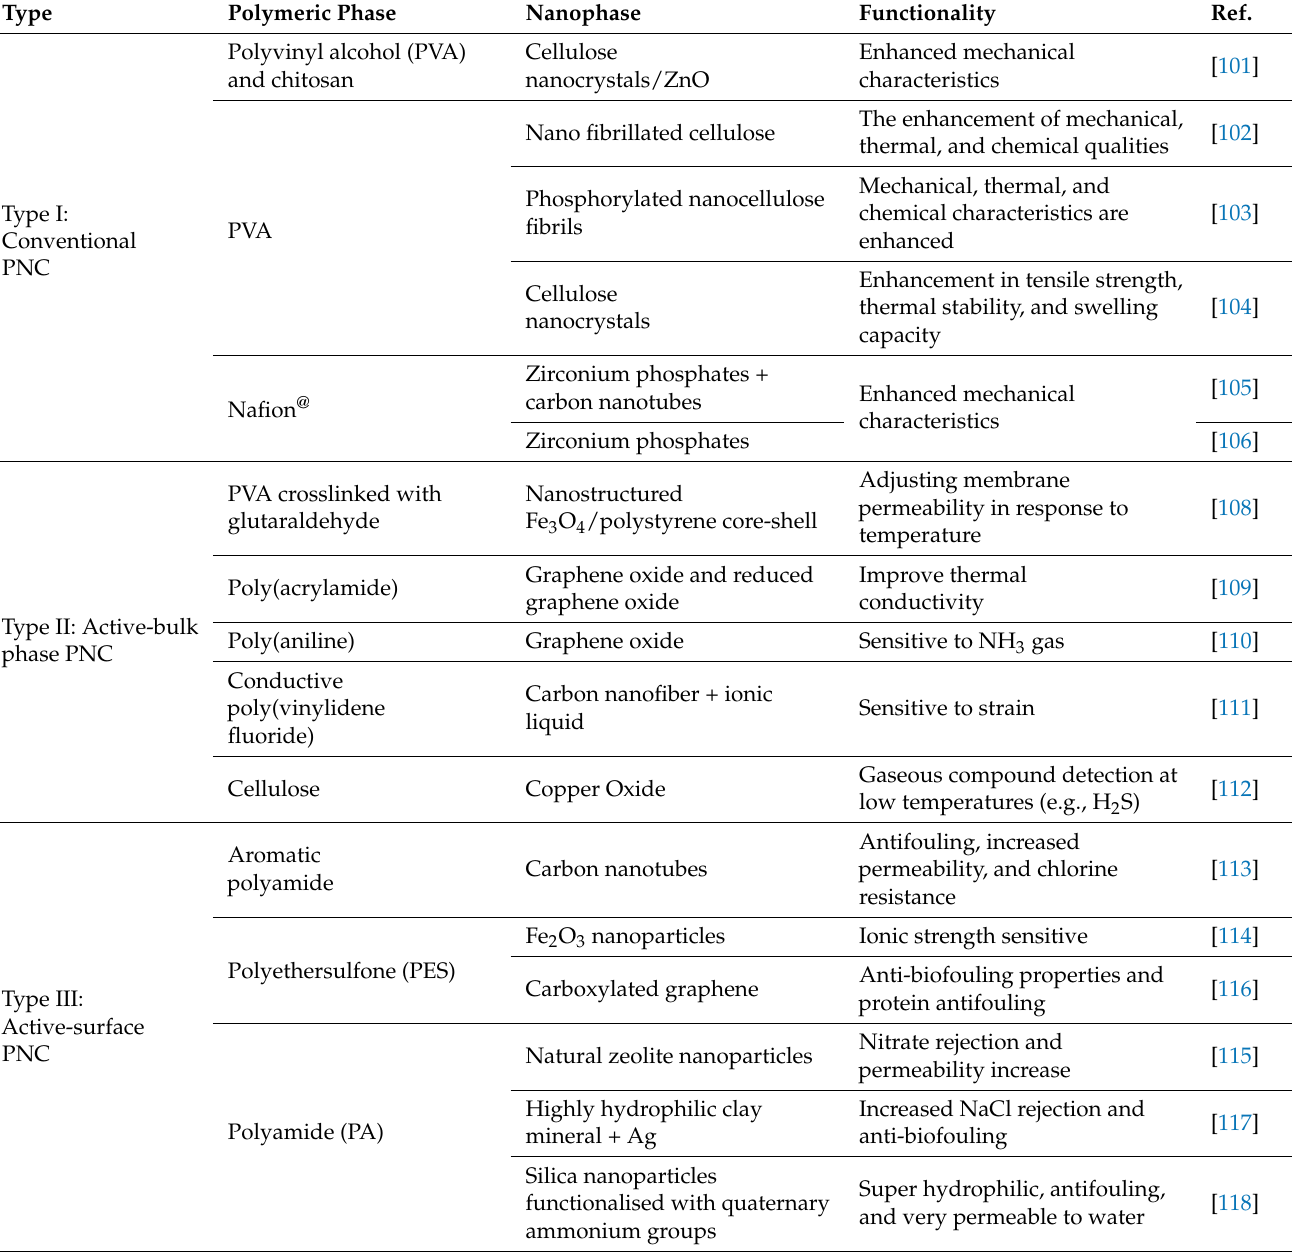
Table 1. Polymeric nanocomposite membranes of various